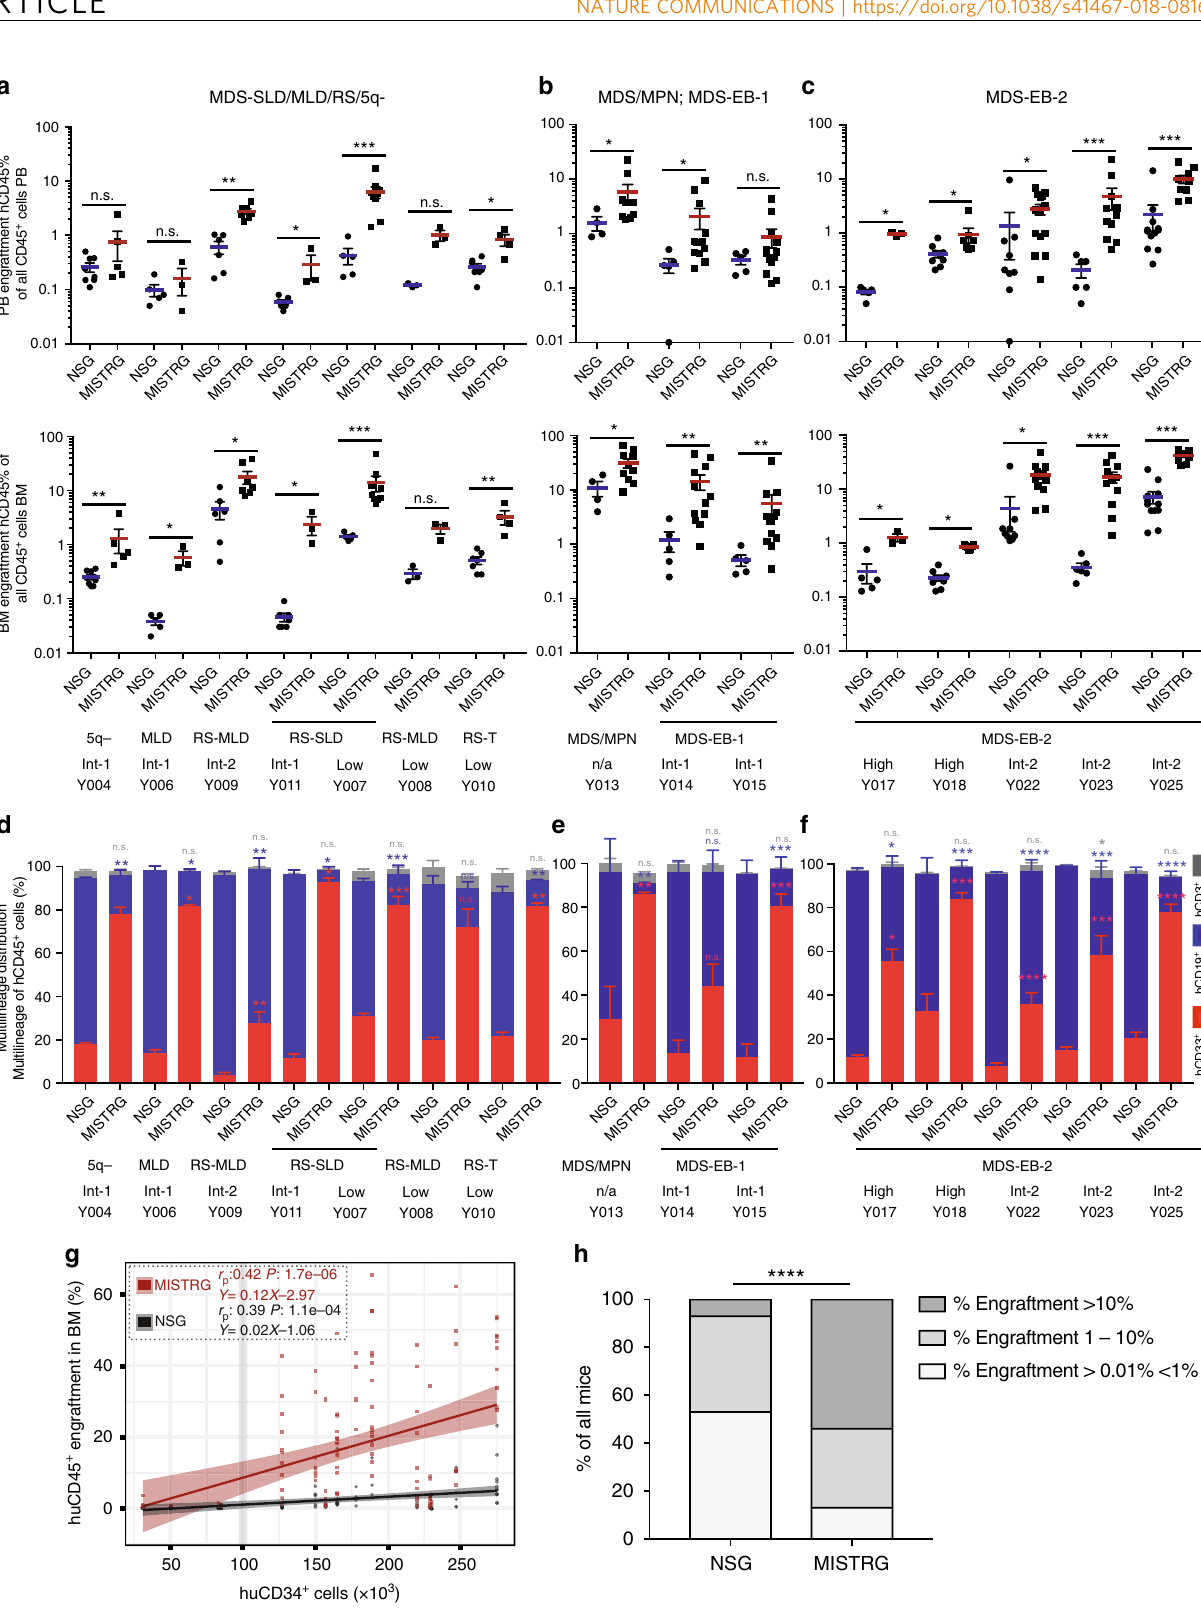
MISTRG and NSG mice (Supplementary Fig 1b), interestingly with similar engraftment in female and male mice of the respective strains (Supplementary Figure 3d), not seen with engraftment in adult NSG mice in previous studies 27 . As